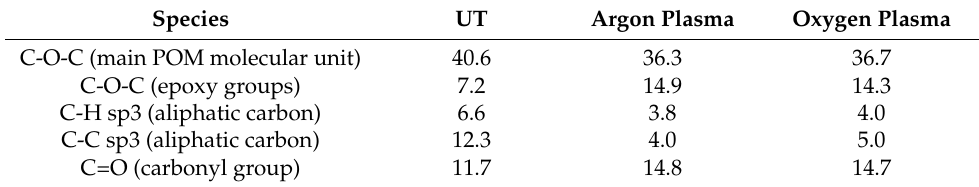
Figure 4. IR ATR spectra of untreated and plasma-treated POM. Table 2. XPS data C1s obtained for the untreated and plasma-treated samples.